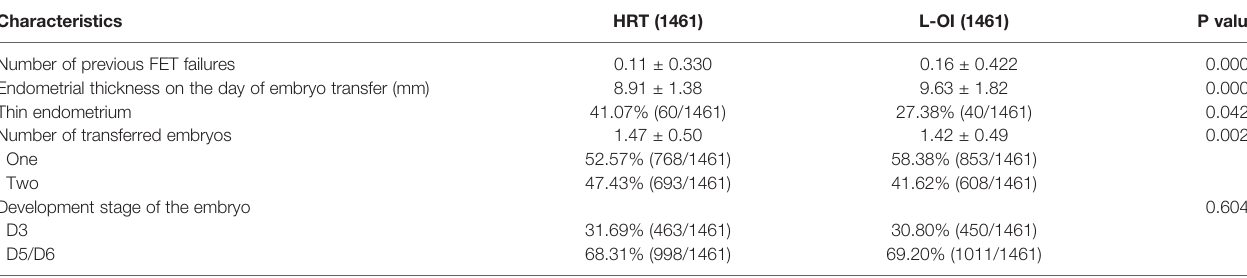
TABLE 3 | Patient clinical and embryological characteristics. Characteristics